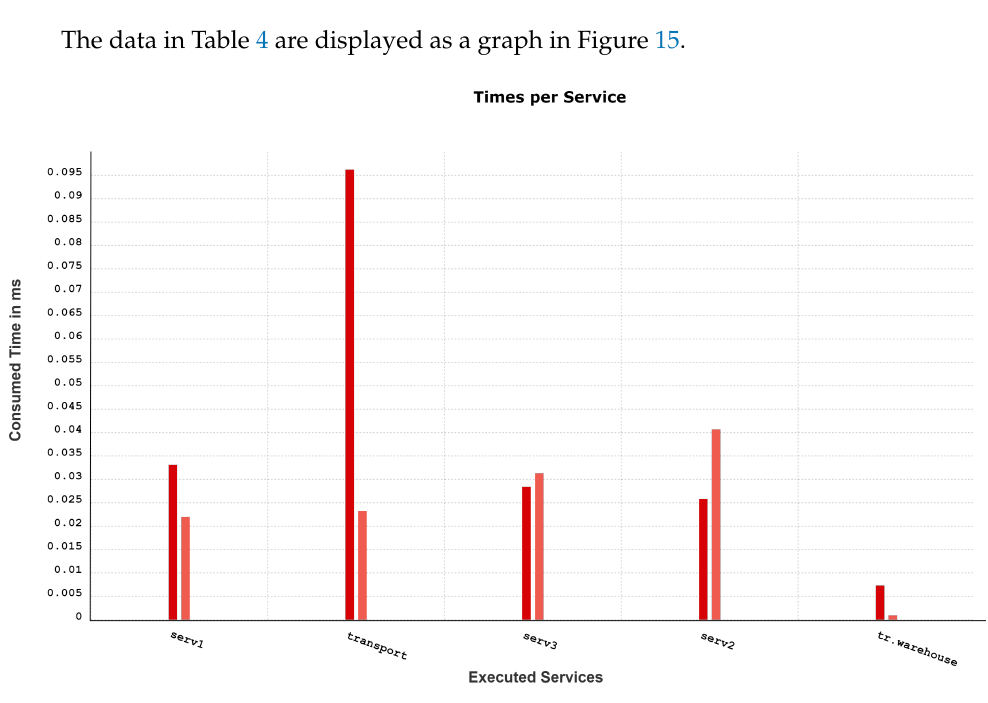
Figure 15. Sample graph based on file content with run times per